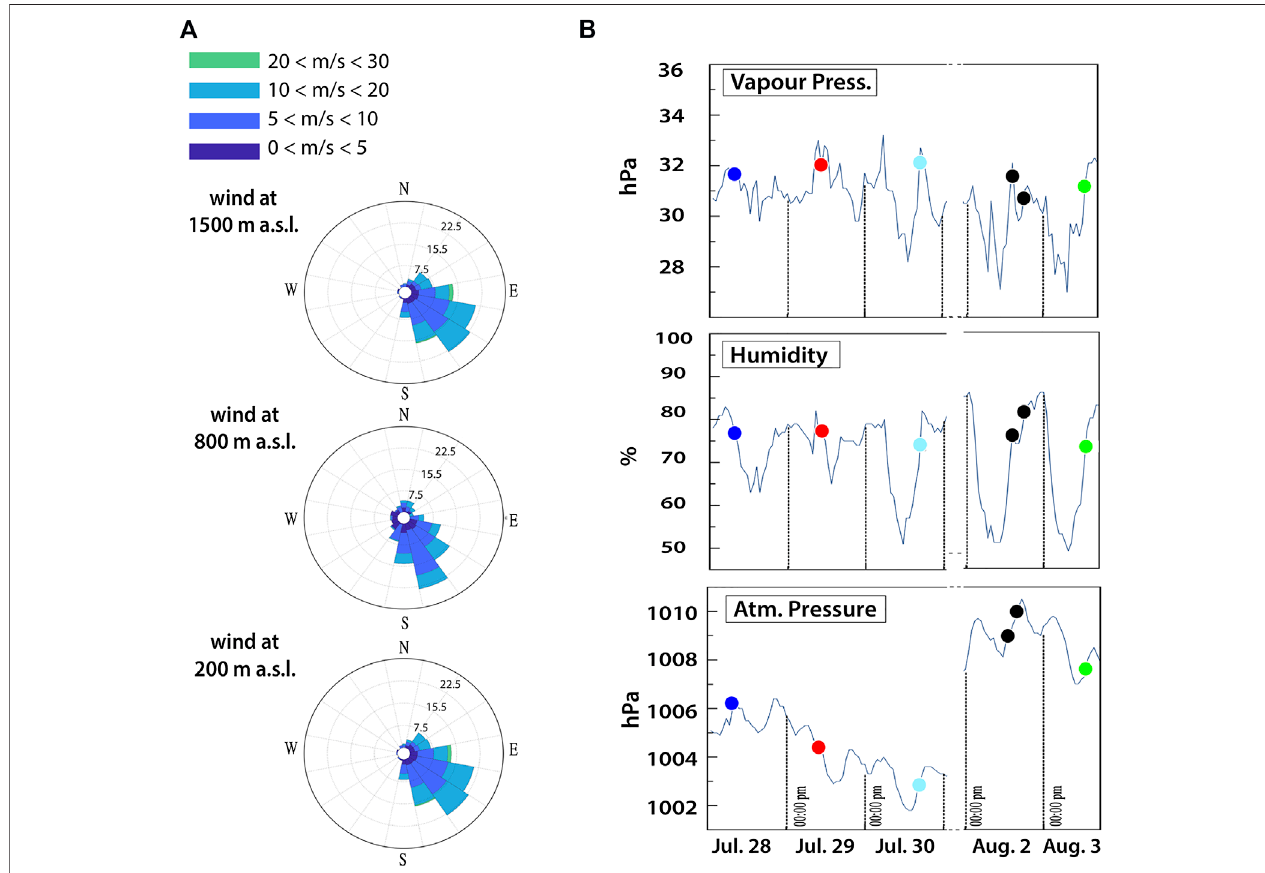
FIGURE2| MeteorologicalconditionsmeasuredatSakurajimaduringtheperiodofsamplecollection(July28 – August3). (A) Cumulativerosediagramsofthewind direction measured at different height above sea level during the full period of data collection; (B) time variation of the most relevant meteorological parameters (vapor pressure,humidityandatmosphericpressure).ColoredcirclesindicatethemeteorologicalconditionsattheexacttimeoftheaggregatecollectionwithHS-HRvideoand SEM tapes (same color as in Figure 1 representing different days of collection).